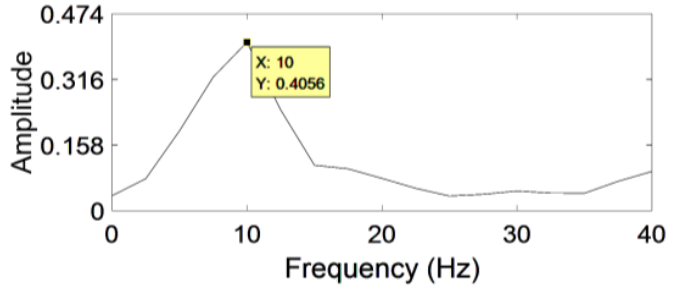
Figure 32. SCR = 1.16 in PI control system.